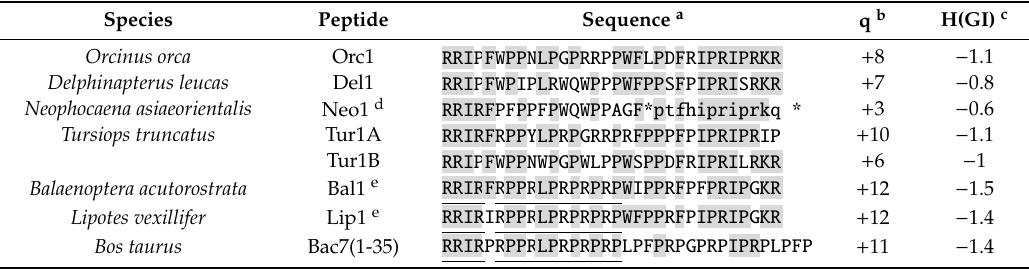
Table 1. Sequence and physico-chemical properties of cetacean cePrAMPs, identified by genome mining, compared to the active N-terminal fragment of the bovine PrAMP Bac7(1-35). Species Peptide Sequence a q b H(GI) c Orcinus orca Orc1 RRIPFWPPNLPGPRRPPWFLPDFRIPRIPRKR + 8 − 1.1 Delphinapterus leucas Del1 RRIPFWPIPLRWQWPPPWFPPSFPIPRISRKR + 7 − 0.8 Neophocaena asiaeorientalis Neo1 d RRIRFPFPPFPWQWPPAGF*ptfhipriprkq * + 3 − 0.6 Tursiops truncatus Tur1A RRIRFRPPYLPRPGRRPRFPPPFPIPRIPRIP + 10 − 1.1 Tur1B RRIPFWPPNWPGPWLPPWSPPDFRIPRILRKR + 6 − 1 Balaenoptera acutorostrata Bal1 e RRIRFRPPRLPRPRPRPWIPPRFPFPRIPGKR + 12 − 1.5 Lipotes vexillifer Lip1 e RRIRIRPPRLPRPRPRPWFPPRFPIPRIPGKR + 12 − 1.4 Bos taurus Bac7(1-35) RRIRPRPPRLPRPRPRPLPFPRPGPRPIPRPLPFP + 11 −